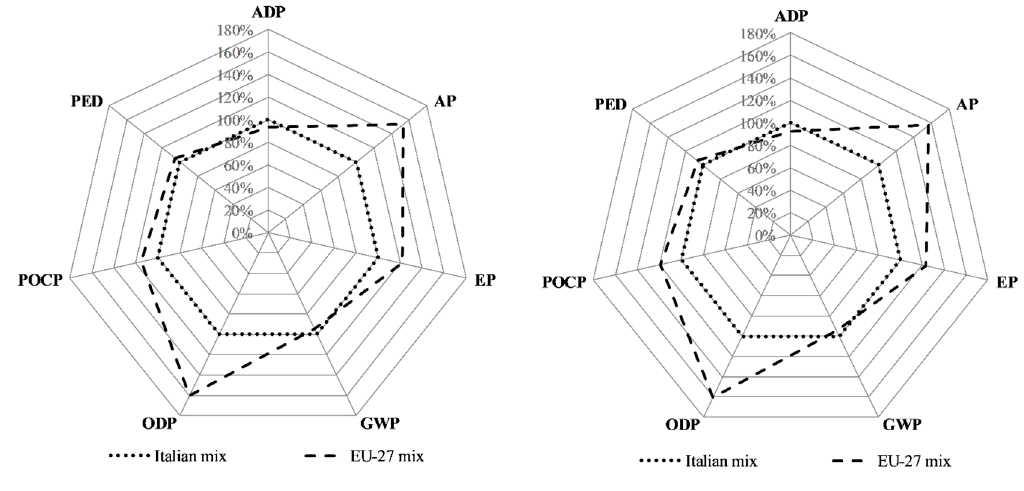
Figure 11. Sensitivity analysis of the second and third scenario.